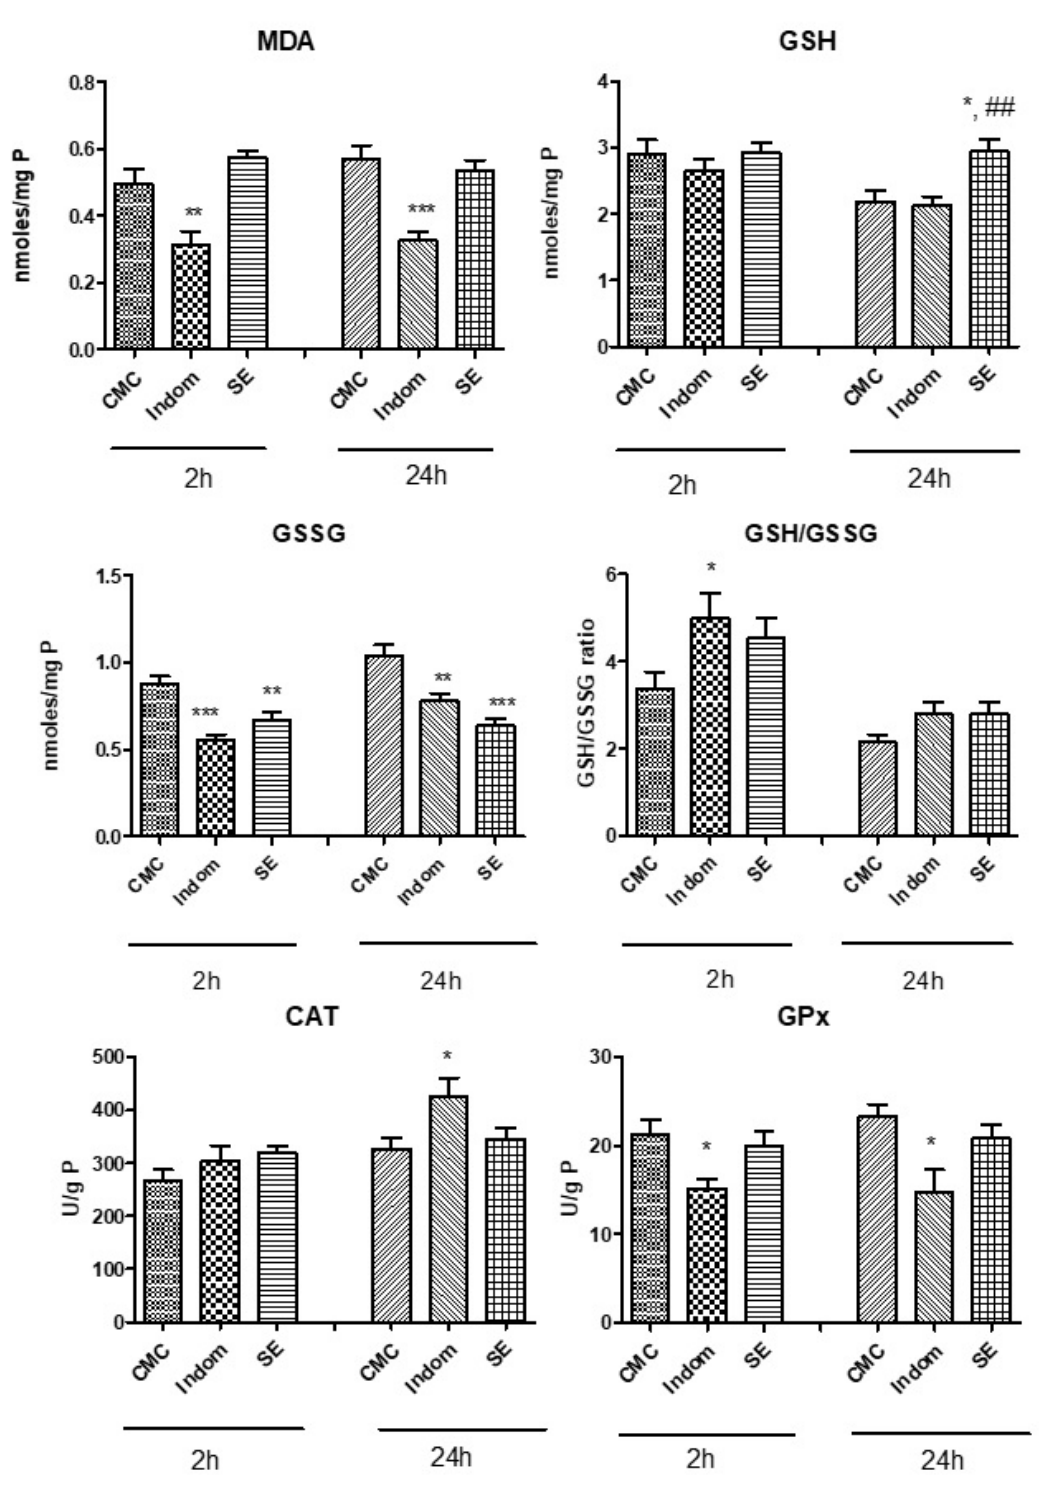
Figure 1. The effect of SE administration on MDA, GSH and GSSG levels, GSH/GSSG ratio, CAT and GPx activities in rat paw tissues at 2 h and 24 h after injection of carrageenan. Values are expressed as means ± SD. Statistical analysis was done by a one-way ANOVA, with Tukey’s multiple comparisons post-test (* p < 0.05 and ** p < 0.001, *** p < 0.0001, all groups vs. control group; ## p < 0.01 vs. Indom